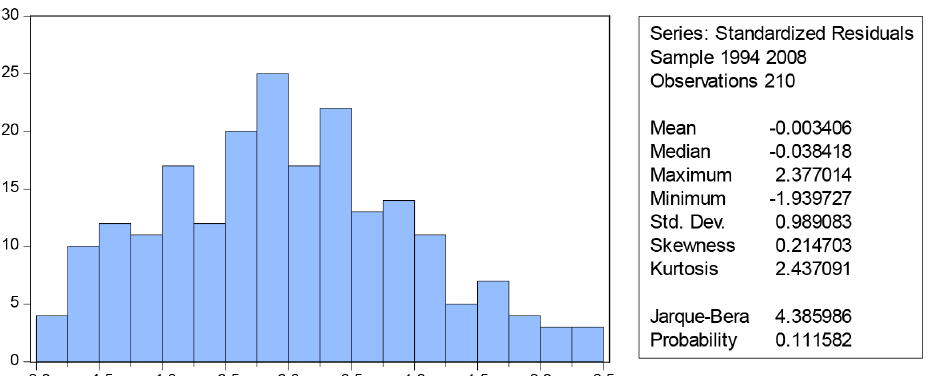
Fig. 4. Tests of residual normality for the EU-14